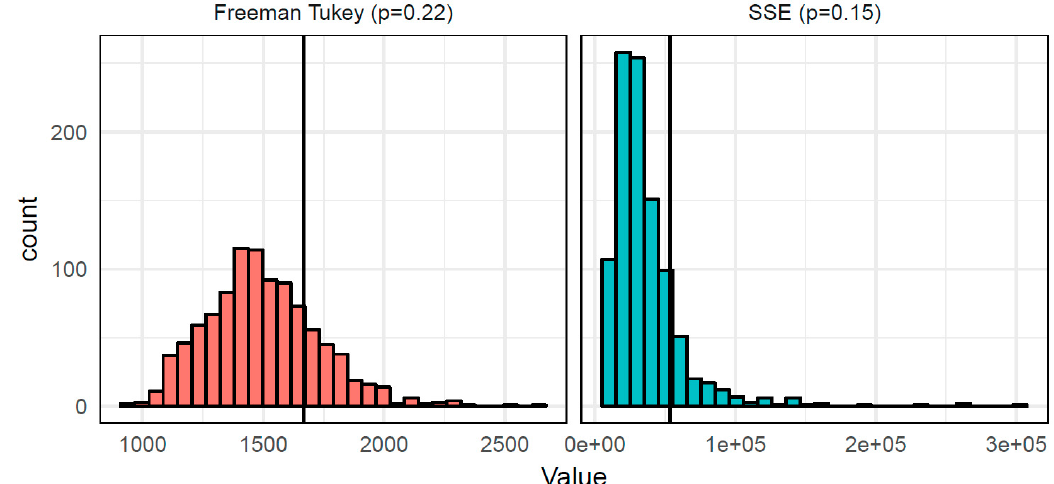
Figure 4. Visualization of the goodness of fit test results for the AIC-top model. The histograms show the bootstrapped (simulated) test statistics with the associated p -value in the title ( left : Freeman Tukey, right : SSE). The vertical black line shows the observed test statistic and demonstrates that it is a reasonable assumption that the data could arise from the model used for inference.